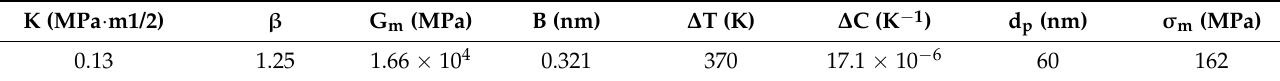
Table 3. The parameter values for calculating the theoretical yield